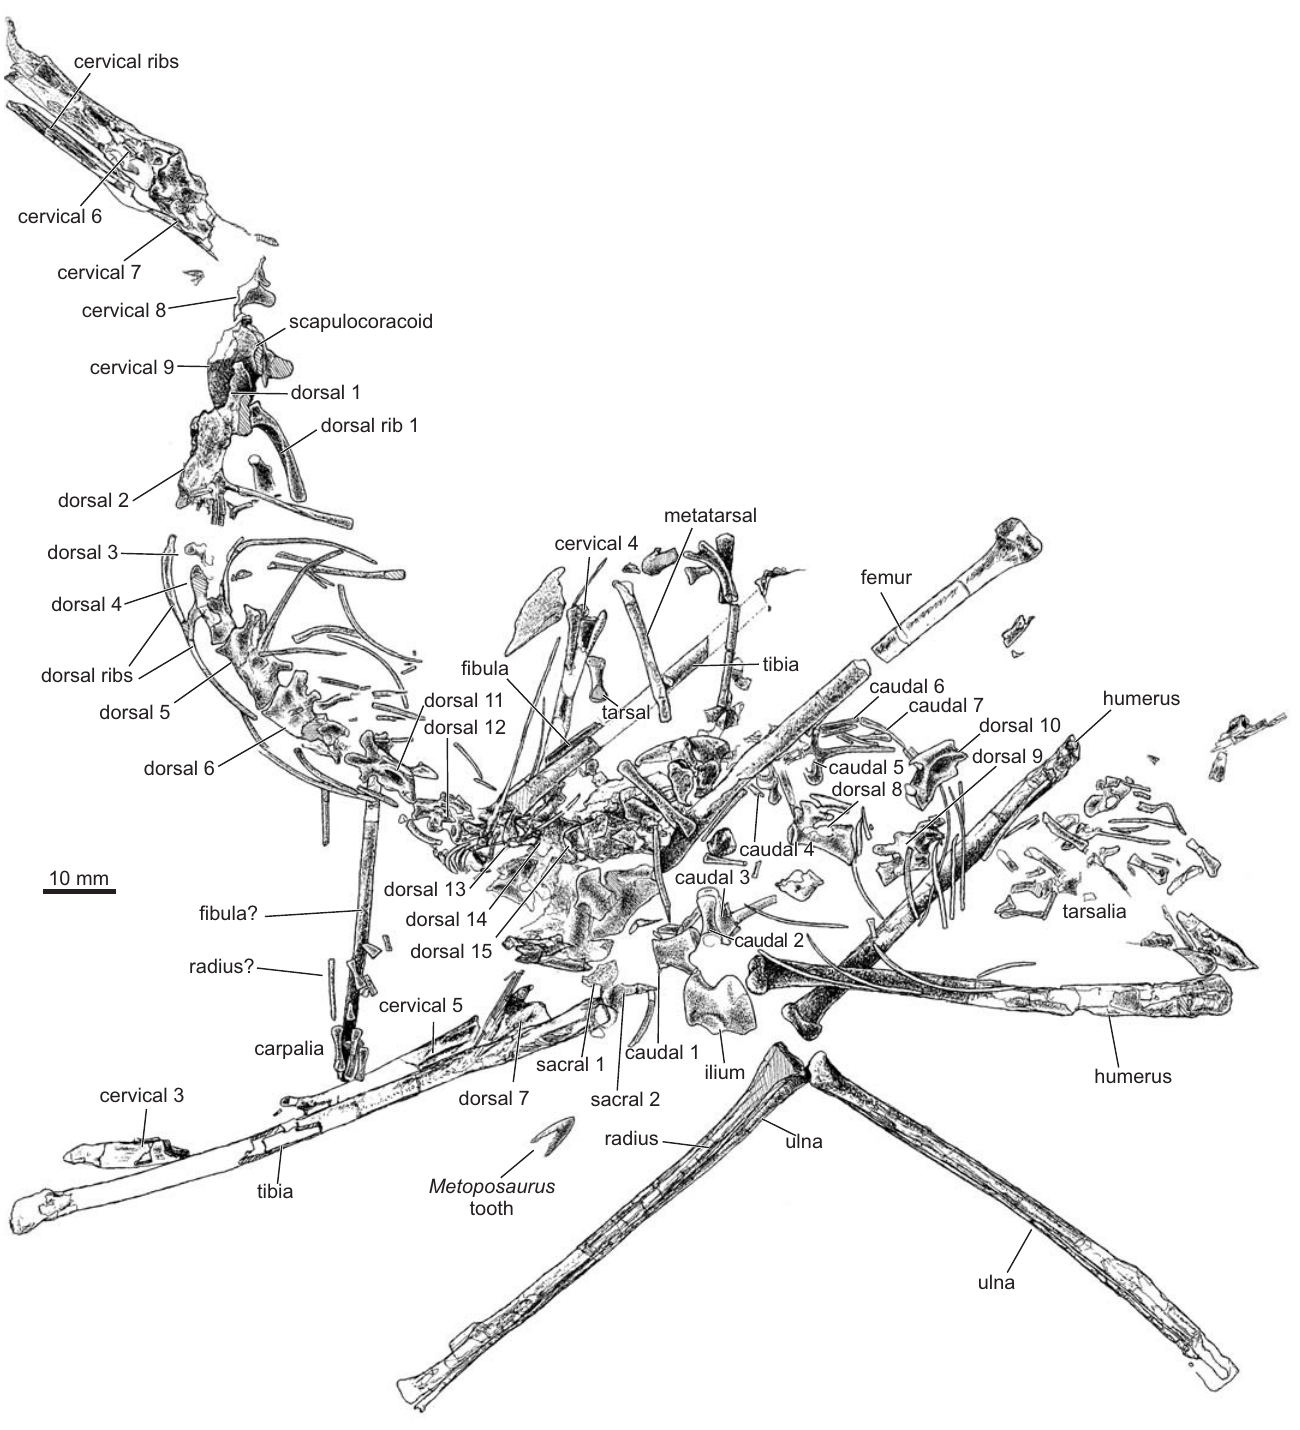
Fig. 4. Composite drawing of skeleton ZPAL AbIII/2511 of long-necked reptile Ozimek volans gen. et sp. nov. with bones from all layers superimposed (see photographs Figs. 5,